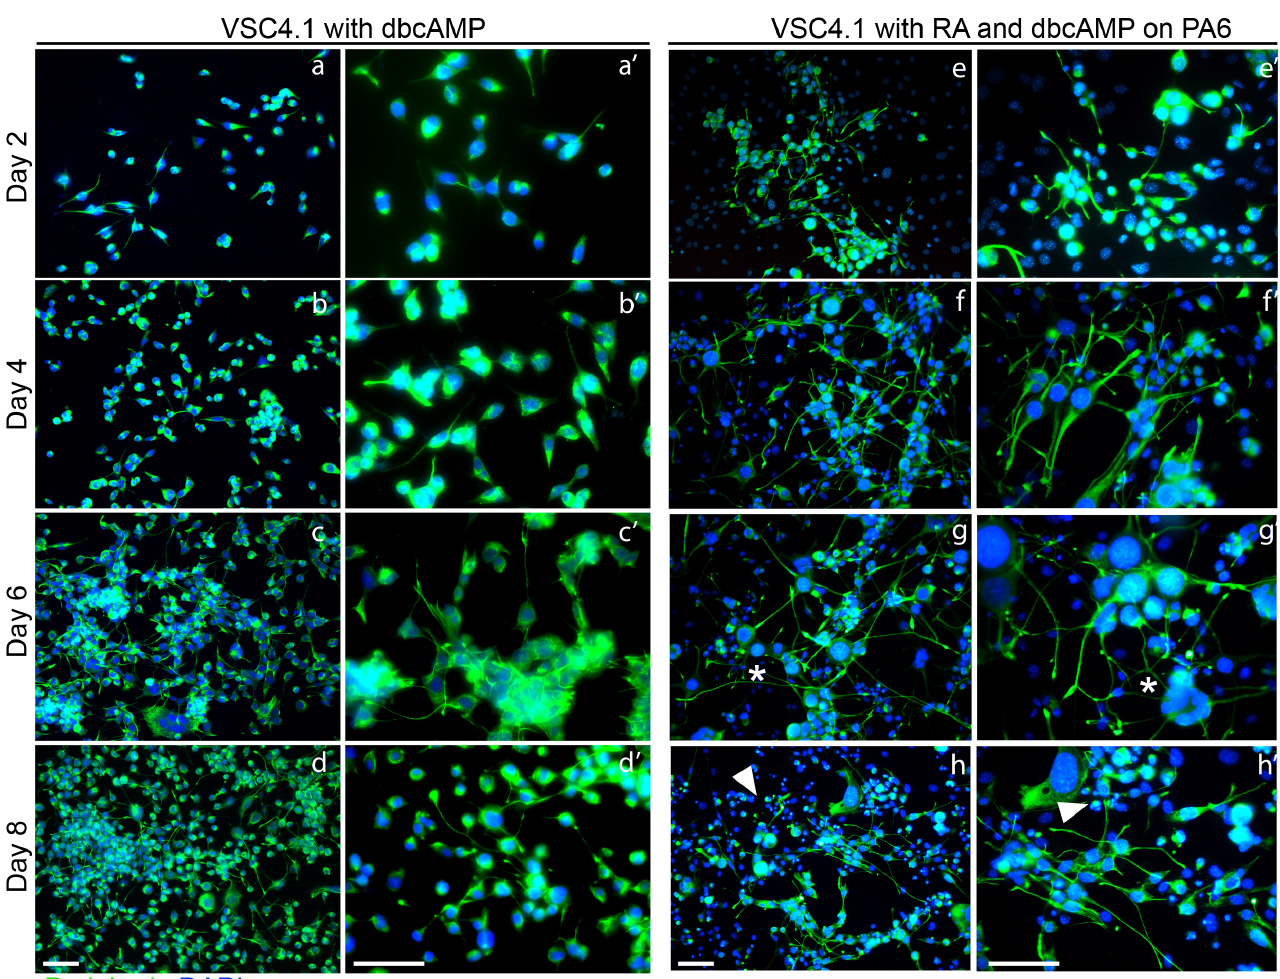
Fig 3. Differentiation of VSC4.1 on PA6 under optimised conditions. Immunostaining for peripherin in a time course of differentiation of VSC4.1 with dbcAMP alone or in combination with RA and PA6. In the absence of RA and PA6 (a-d), short peripherin positive neurites and continued proliferation are seen. Differentiation with RA and dbcAMP on PA6 (e-h) resulted in reduced proliferation and extensive neurite projection. Differentiated VSC4.1 also appear to have slightly enlarged nuclei and thicker neurites as the differentiation progresses. (a ’ -h ’ ) higher magnifications of the same time point. Scale bars 50 μ m.